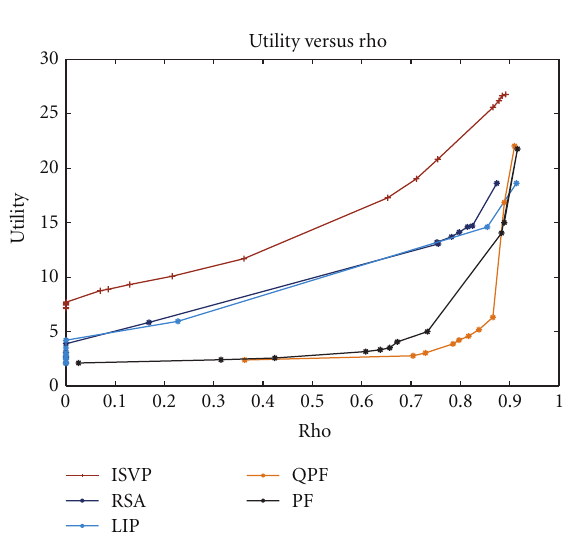
Figure 9: Utility ( (cid:26) Ψ ) versus Rho ( (cid:27) ρ d